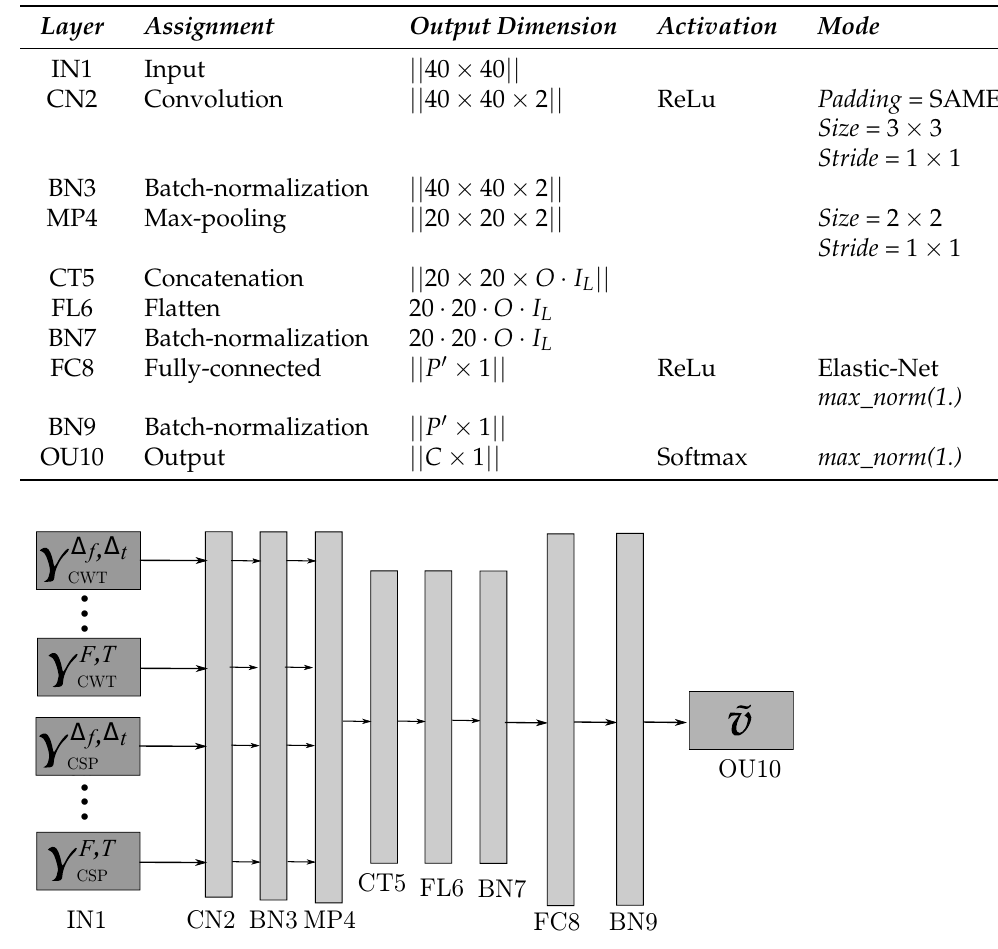
Figure 3. Partitions of individuals clustered by the MLP-based accuracy. Each subject performance is painted by his estimated BCI inefficiency partition: Group I (green), Group II (yellow), and Group III (red). 3.3. Performed stepwise multi-space kernel matching 260